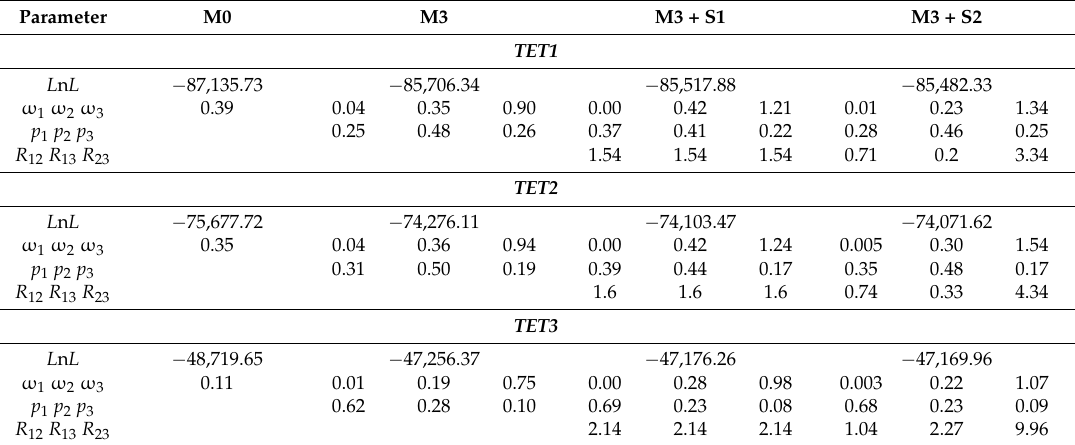
Table 3. Likelihood analysis of the models in the Fitmodel program for the TET gene sequence data. Parameter